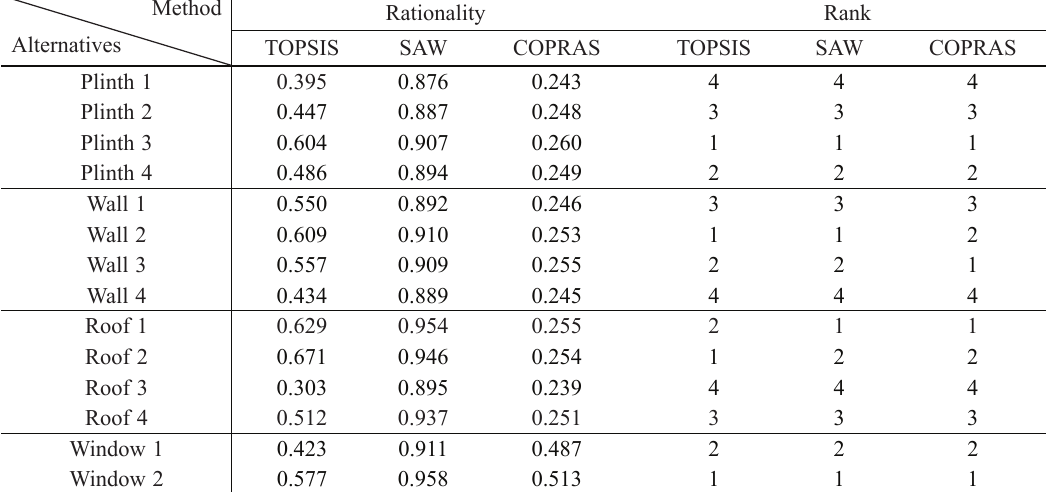
table 4. the significance of the alternatives and ranks obtained using tOPSiS, SAW and COPRAS methods